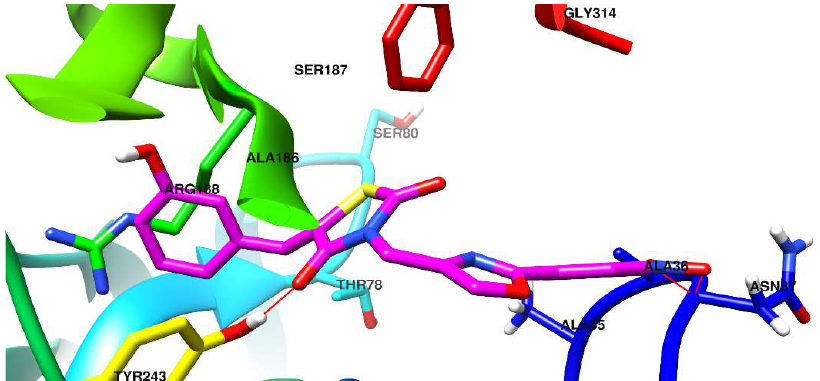
Figure 4. Compound 5d docked in the binding site of the C. albicans Als1 surface protein.